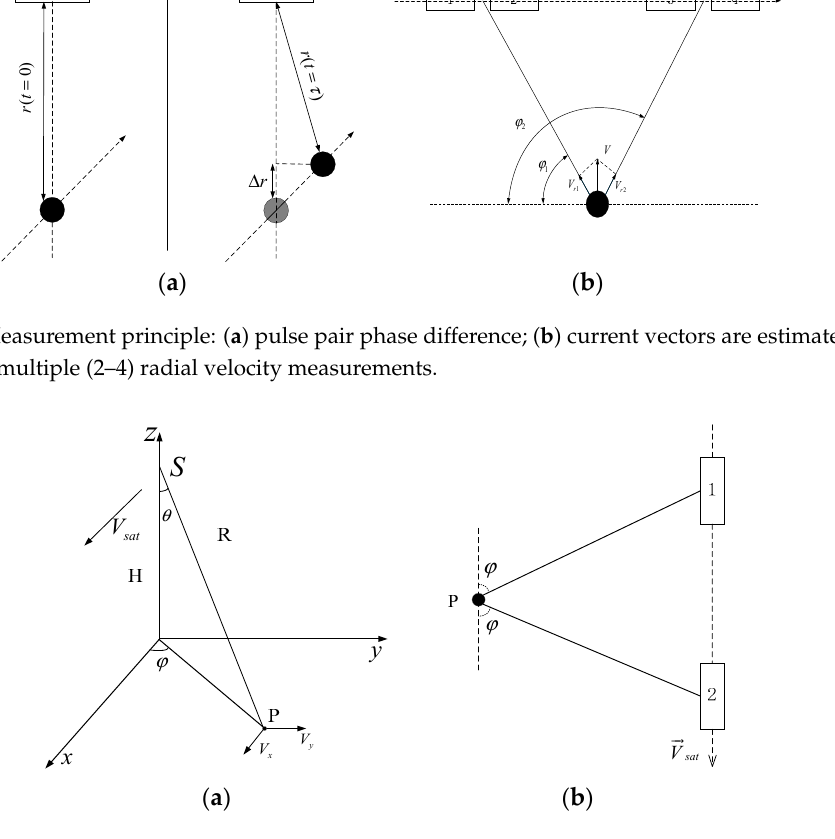
Figure 9. Observation geometry of the pencil beam rotating scatterometer: ( a ) three-dimensional view; ( b ) different azimuth angle relations.